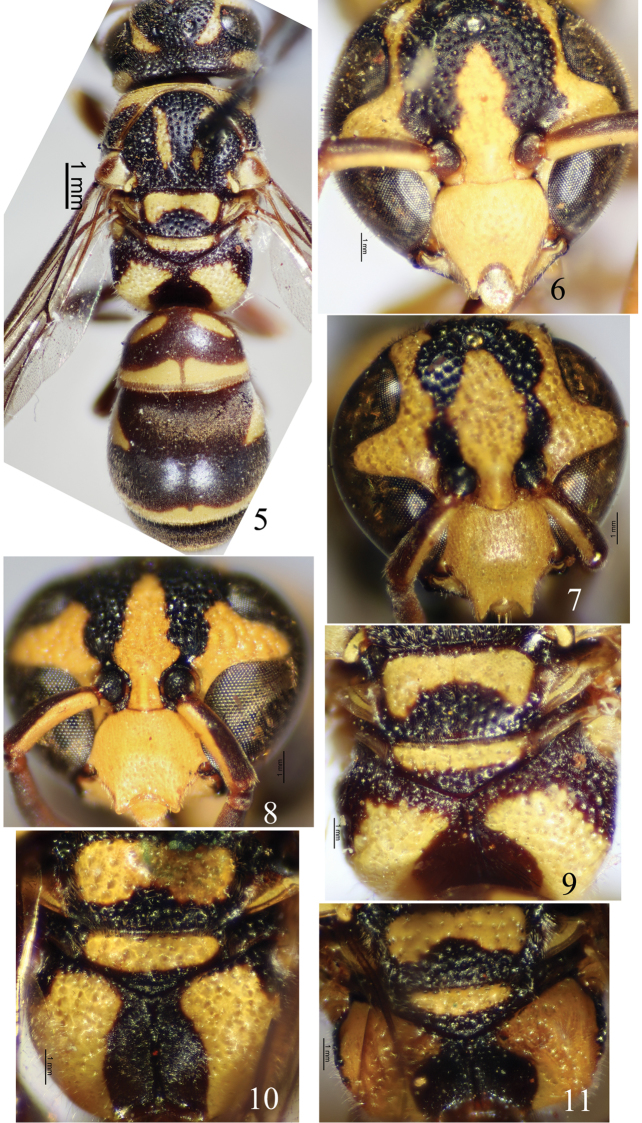
5, 6, 9Stenodyneriellusangustus sp. n. 7, 10Stenodyneriellusflaviventris8, 11Stenodyneriellusoctolineatus5 habitus of holotype (dorsal view) 6–8 clypeus (frontal view) 9–11 propodeum (dorsal view).